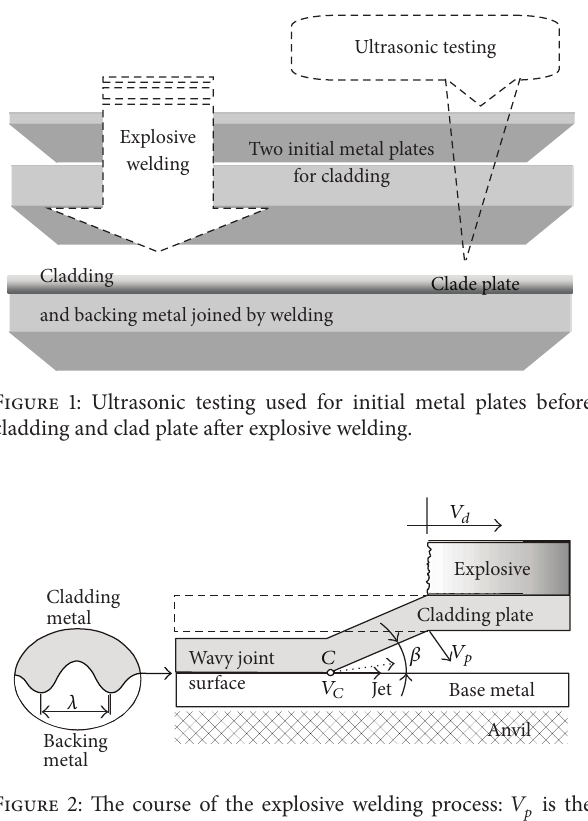
Figure 3: The ultrasonic echo responses of the point defect (a) 1 amplitude, 2 A scan (static envelope), 3 range, 4 variation of peak signal amplitude (dynamic envelope), 5 probe position, and 6 reflector; beam axis tip location technique (b) 1 and 3 echoes 𝐴 and 𝐴 1 at maximum heights, 2 variation of peak signal amplitude, 4 A scan and 5 echoes 𝐴 and 𝐴 1 will be the first to appear when probe is moved backward and forward; the dimensions of substitute crack